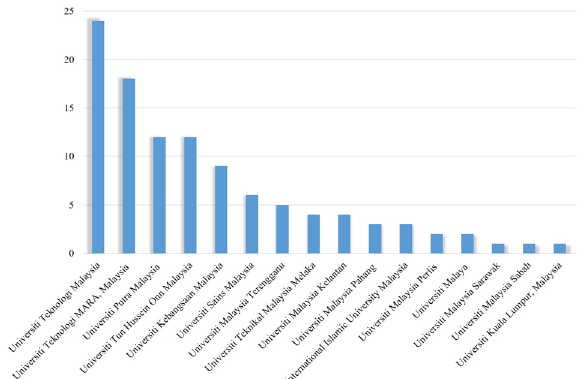
Figure 5. Affiliation appearance of local universities.